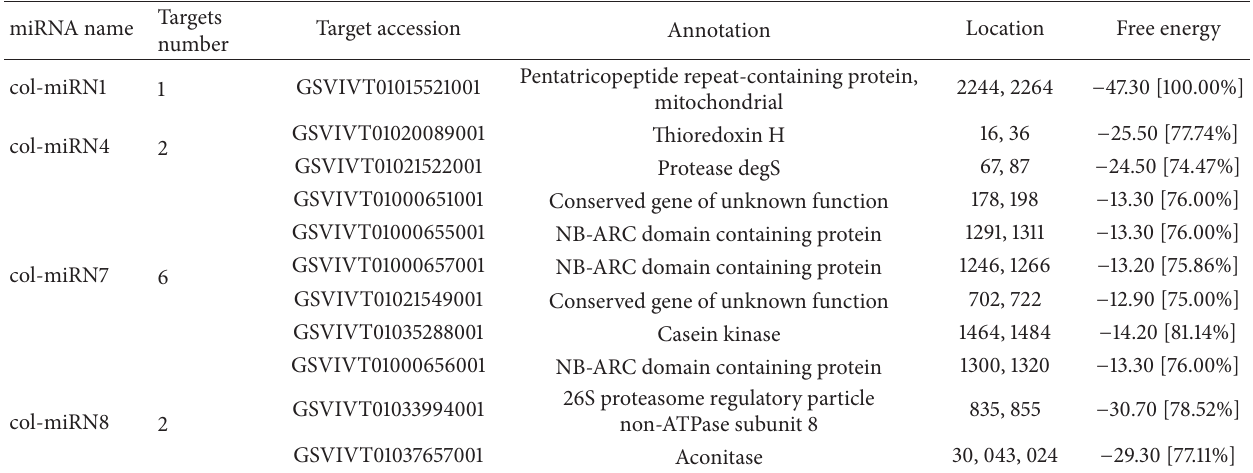
Table 4: Target genes for jute specific